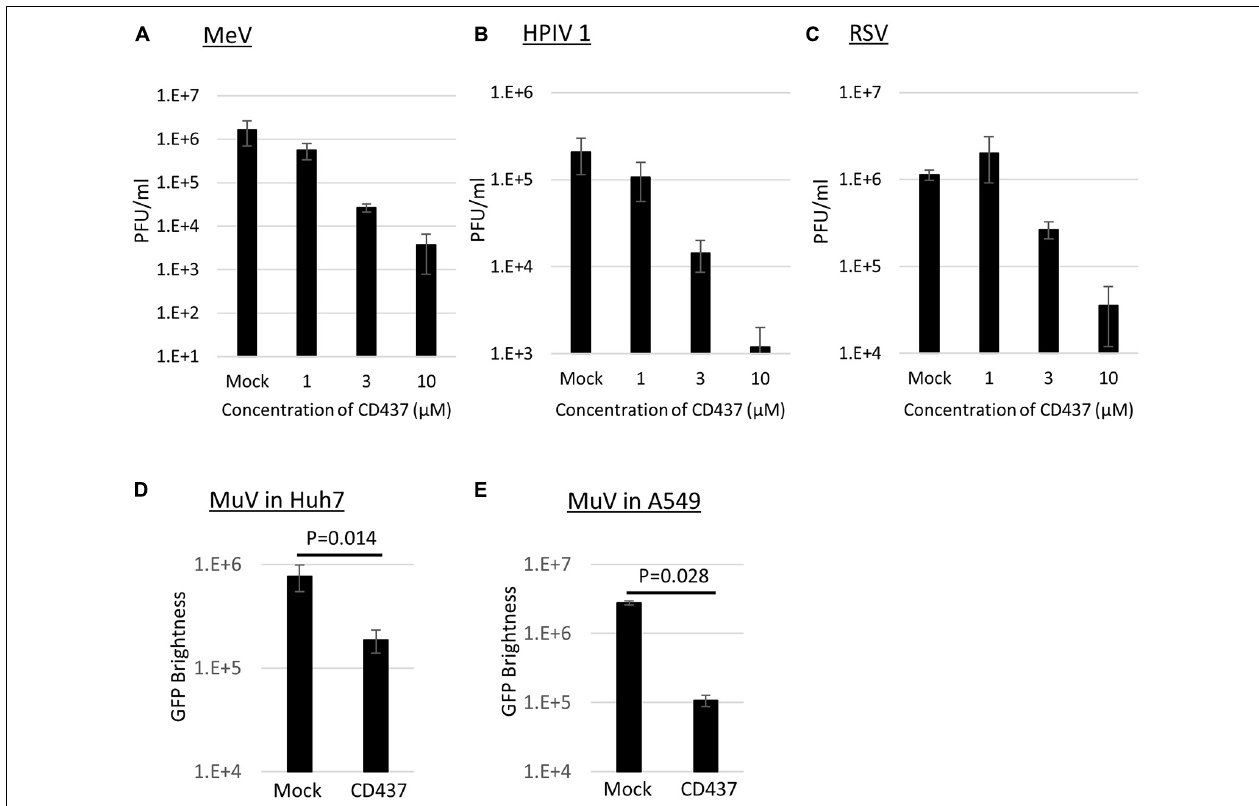
FIGURE 3 | CD437 inhibition of other paramyxoviruses and MuV inhibition in Huh7 and A549 parental cells. (A) MeV, (B) HPIV1, and (C) RSV were inhibited by CD437. A total of 0–10 µ M of CD437 was co-cultured with each virus at an MOI of 0.01. Vero/hSLAM cells were used in MeV, VeroE6/TMPRSS2 cells were used in HPIV1, and Hep2 cells were used in RSV. At 72 h post-infection, the supernatants were collected and the infectious titer was measured using a plaque assay. The EC 50 was calculated using the Reed and Muench method. MuV was inhibited by CD437 in panel (D) Huh7 and (E) parental A547/hSLAM cells. A total of 10 µ M of CD437 was co-cultured with AcGFP-MuV at an MOI of 0.01. At 72 h post-infection, GFP brightness was measured using a fluorescence microscope and image